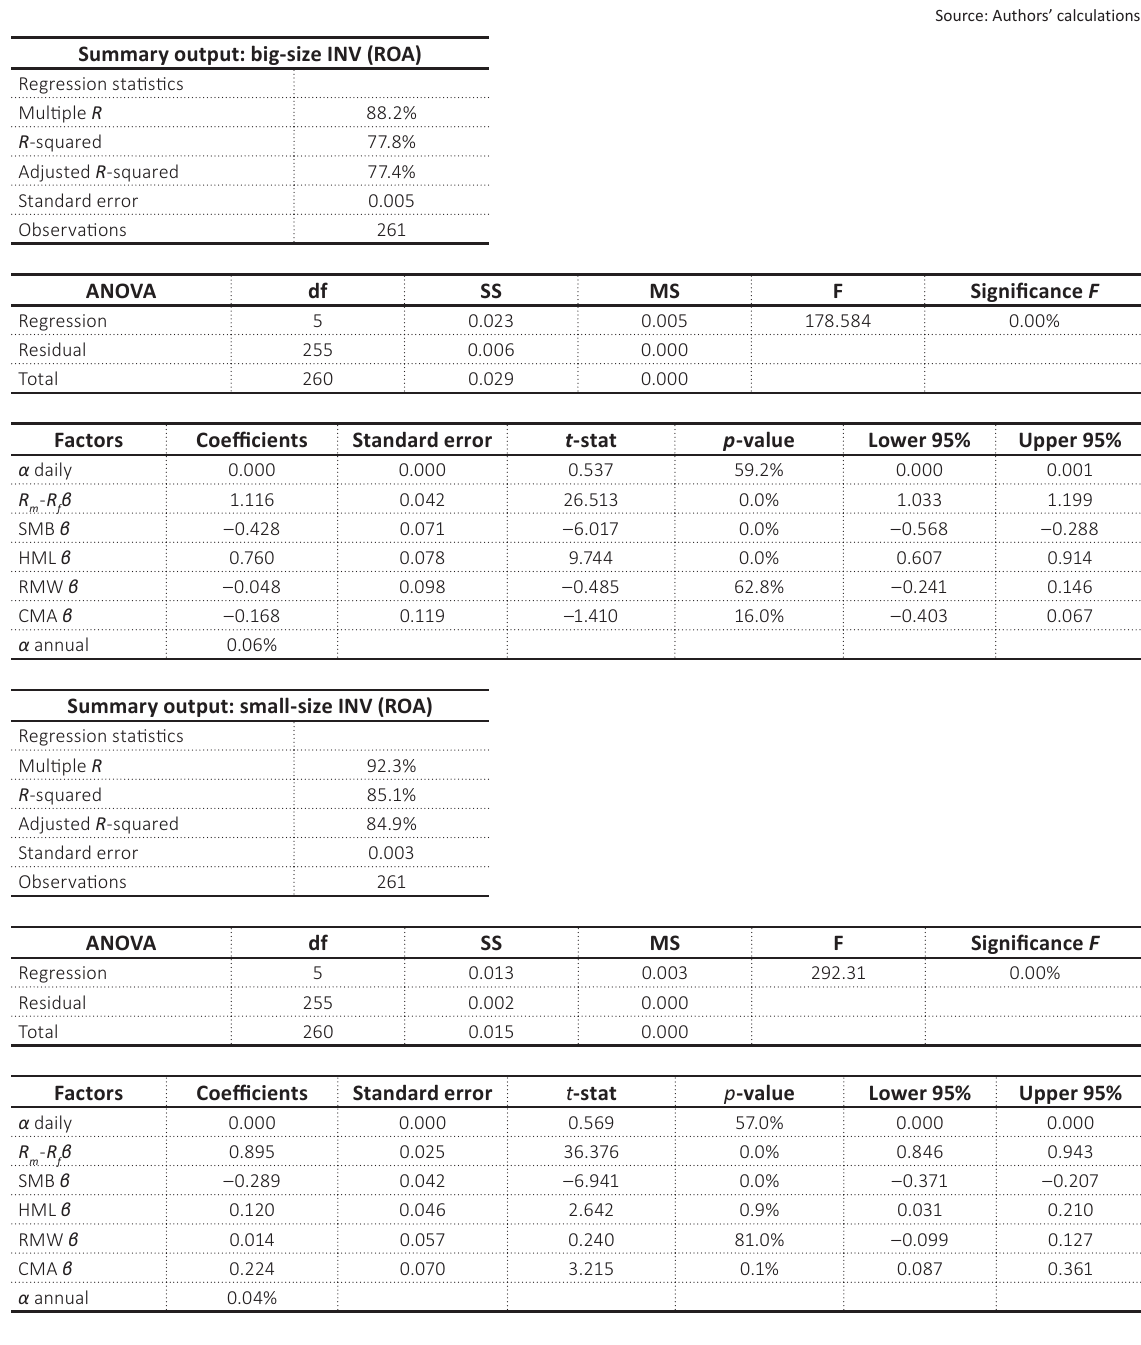
Table A3. ANOVA results for INV group portfolios